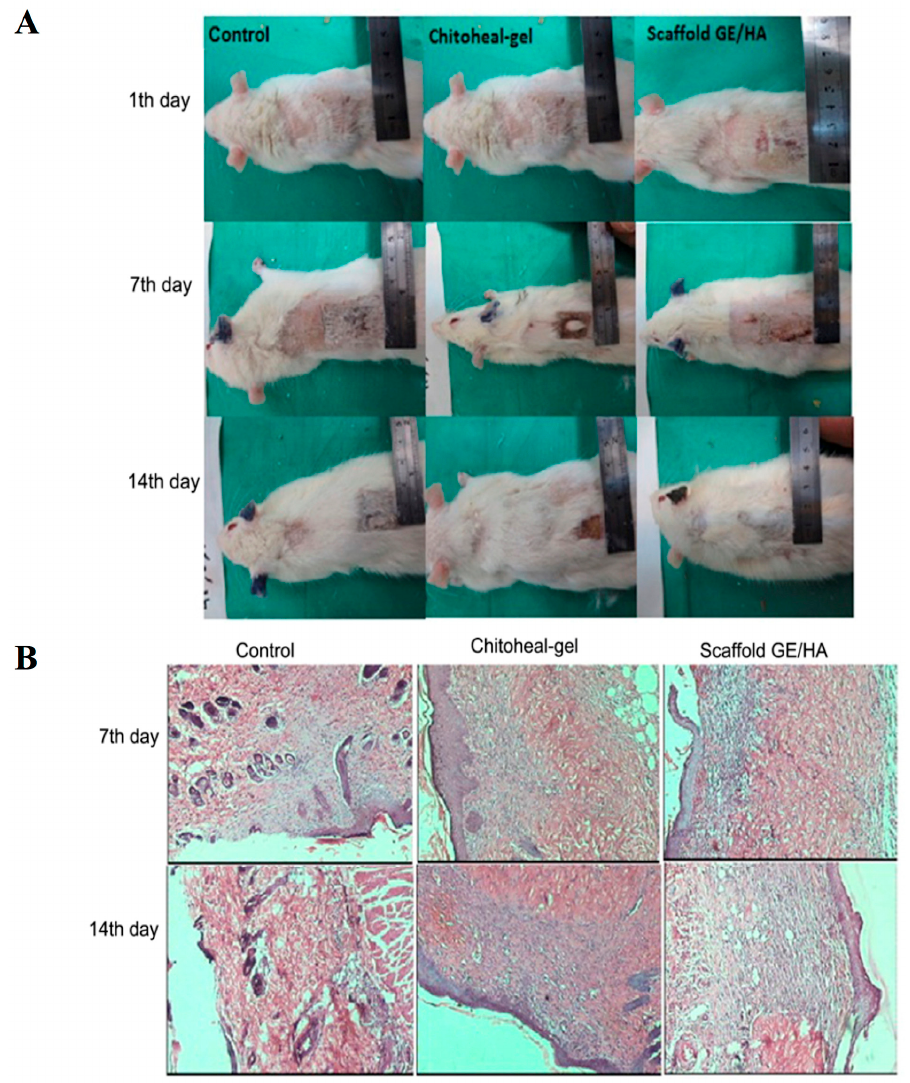
Figure 8. In vivo Evaluation of Gelatin/Hyaluronic Acid Nanofiber as Burn-wound Healing and Its Comparison with ChitoHeal Gel. ( A ) It can be seen that at the end of 14th day GE/HA nanofibrous scaffold is able to completely heal the wound in comparison to chitoheal gel control. ( B ) The H&E stained section of granulation tissue of control, chitoheal gel and GE/HA nanofibrous scaffold shows that irregular collagen bands that are evident in control are absent in GE/HA nanofibrous scaffold. Reproduced with permission from [240].